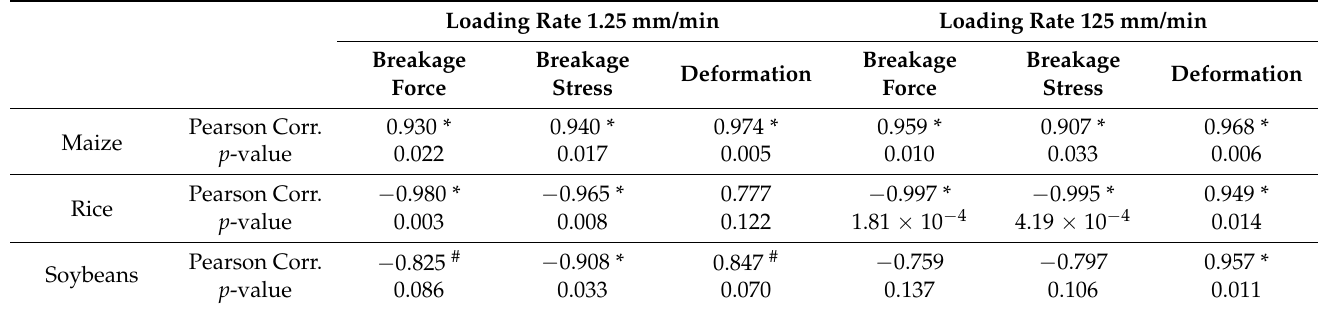
Table 4. Results of correlation analysis between moisture content and mechanical characteristics (based on average values).